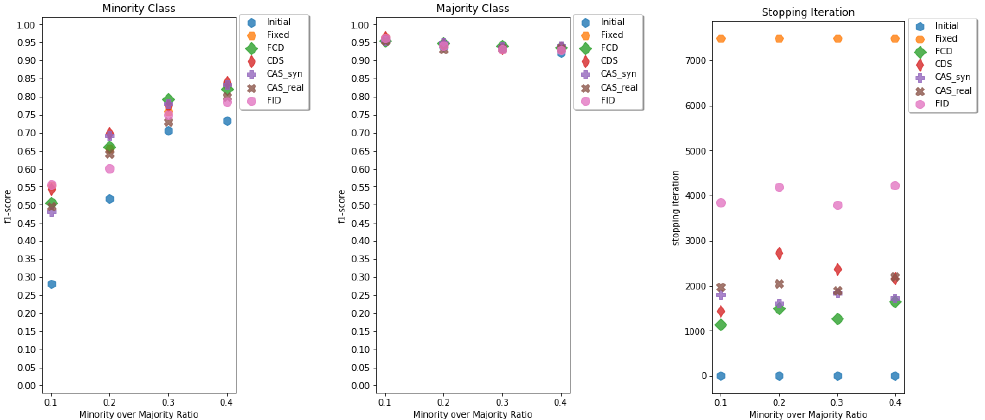
Figure 17. Average F1 results of kmnist12-based datasets by imbalance ratio for minority ( left ) and majority ( center ) classes, and average number of iterations until the training is stopped ( right